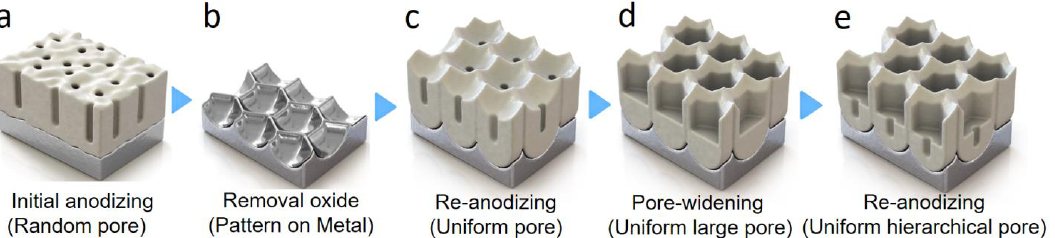
Figure 2. Schematic of the stepwise anodizing process with the intermediate pore-widening step in between for the control of the morphology and hierarchy of the nanopore structures of the alumina layer. ( a ) Initial anodization to create random oxide pores. ( b ) Removal of the oxide layer to leave the pre-pattern on the metal surface. ( c ) Re-anodization to create uniform oxide pores. ( d ) Pore-widening to increase the pore size. ( e ) Re-anodization to create hierarchical oxide pores. Table 2. Stepwise anodizing conditions and the structural dimensions of the anodized nanoporous alumina with an intermediate pore-widening step in